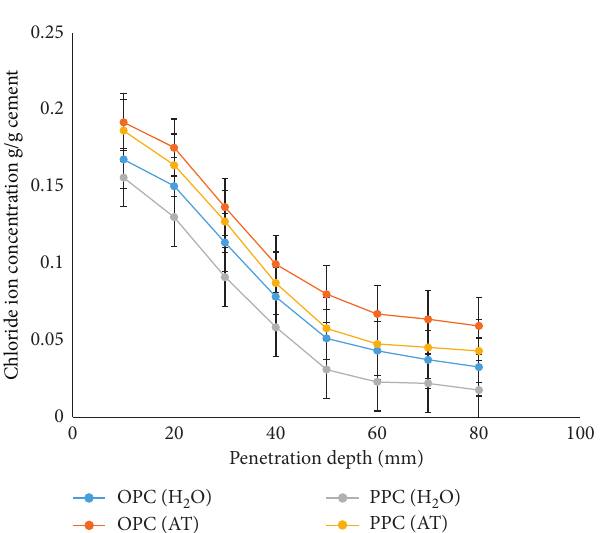
Figure 12: Chloride ion concentration at different depths of penetration for control and microbial exposed mortars.